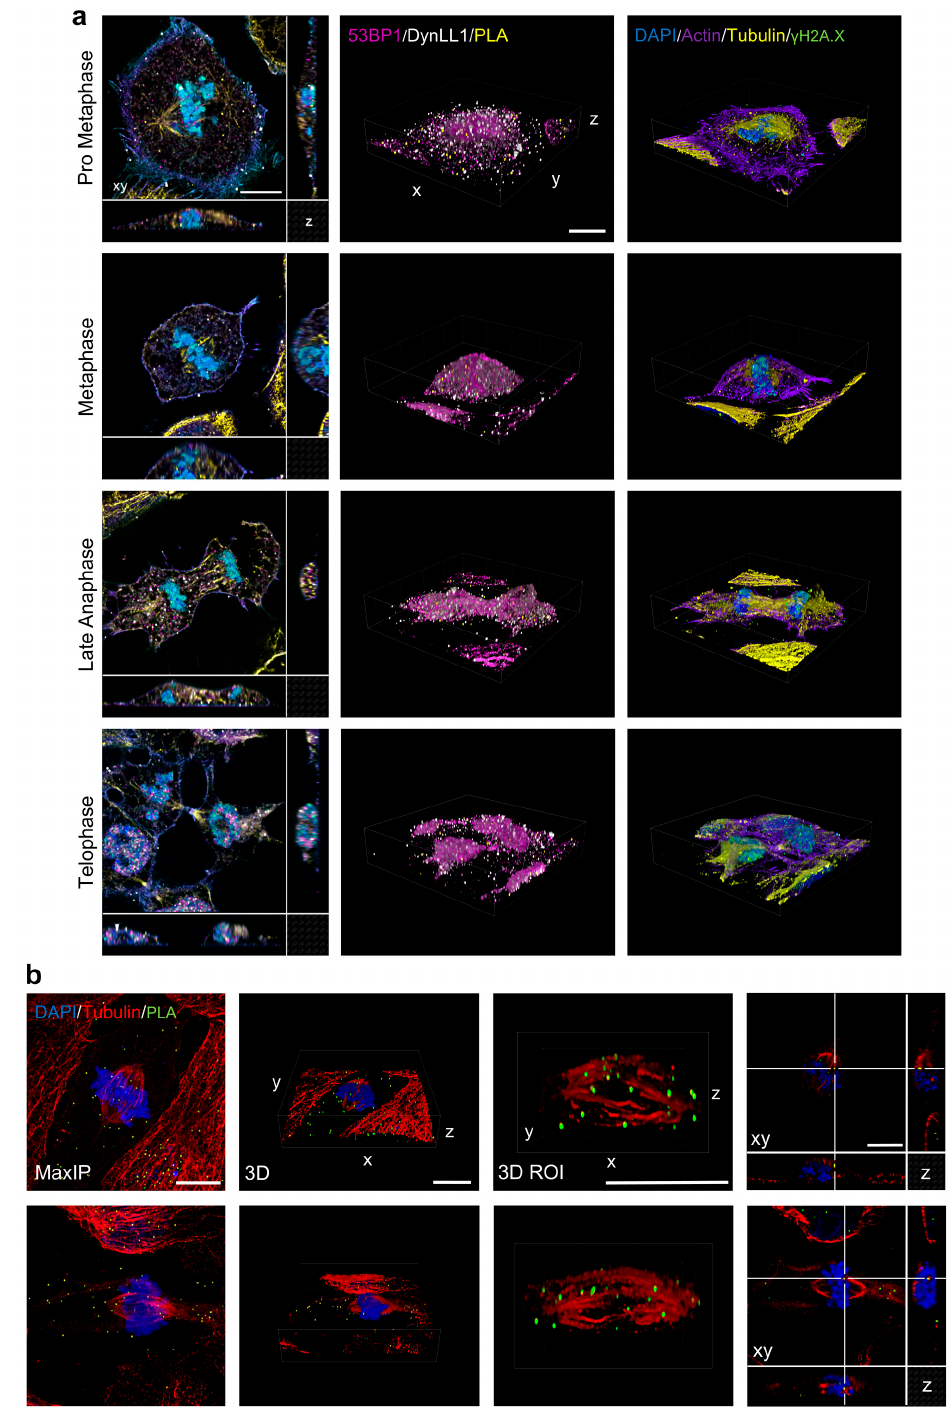
Figure 4. Analysis-Driven Confocal Acquisition of Targeted Mitotic Cells. ( a ) Representative Confocal Stacks of cells in the different stages of mitosis, selected according to the procedure described in the text. The first column shows multiple views, along the optical axis (XY) and lateral planes (XZ, right; YZ, bottom). Three-dimensional volume projections are shown in the second (PLA, 53BP1, DynLL1) and third (DAPI, Actin, Tubulin, γ H2A.X) columns, respectively. ( b ) Representative 3D volume projections and lateral planes’ reconstruction (last column) of PLA, Tubulin, and DAPI signal shows the association of the PLA- interaction spots with the cytoskeleton. Scale bar: 10 µ